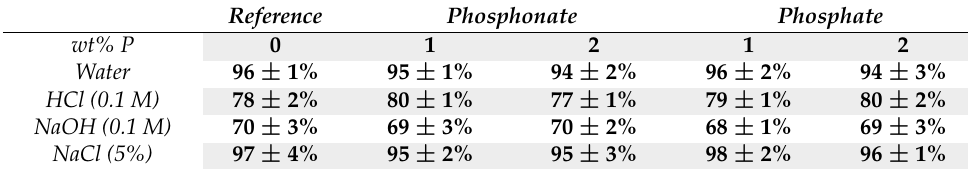
Table 7. Chemical resistances of reference EC alkyd resin and POxCR diluent EC alkyd resins. Reference Phosphonate Phosphate wt% P 0 1 2 1